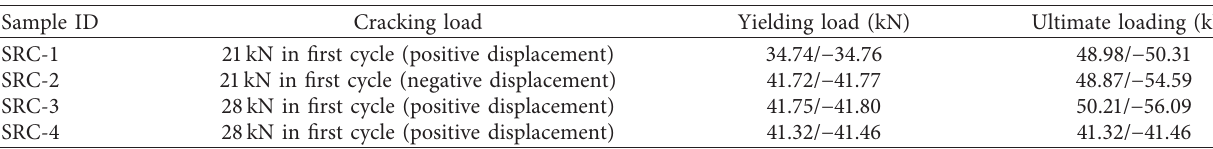
Figure 12: Hysteretic curve and envelope curve for SRC-4. Table 4: Characteristic load.